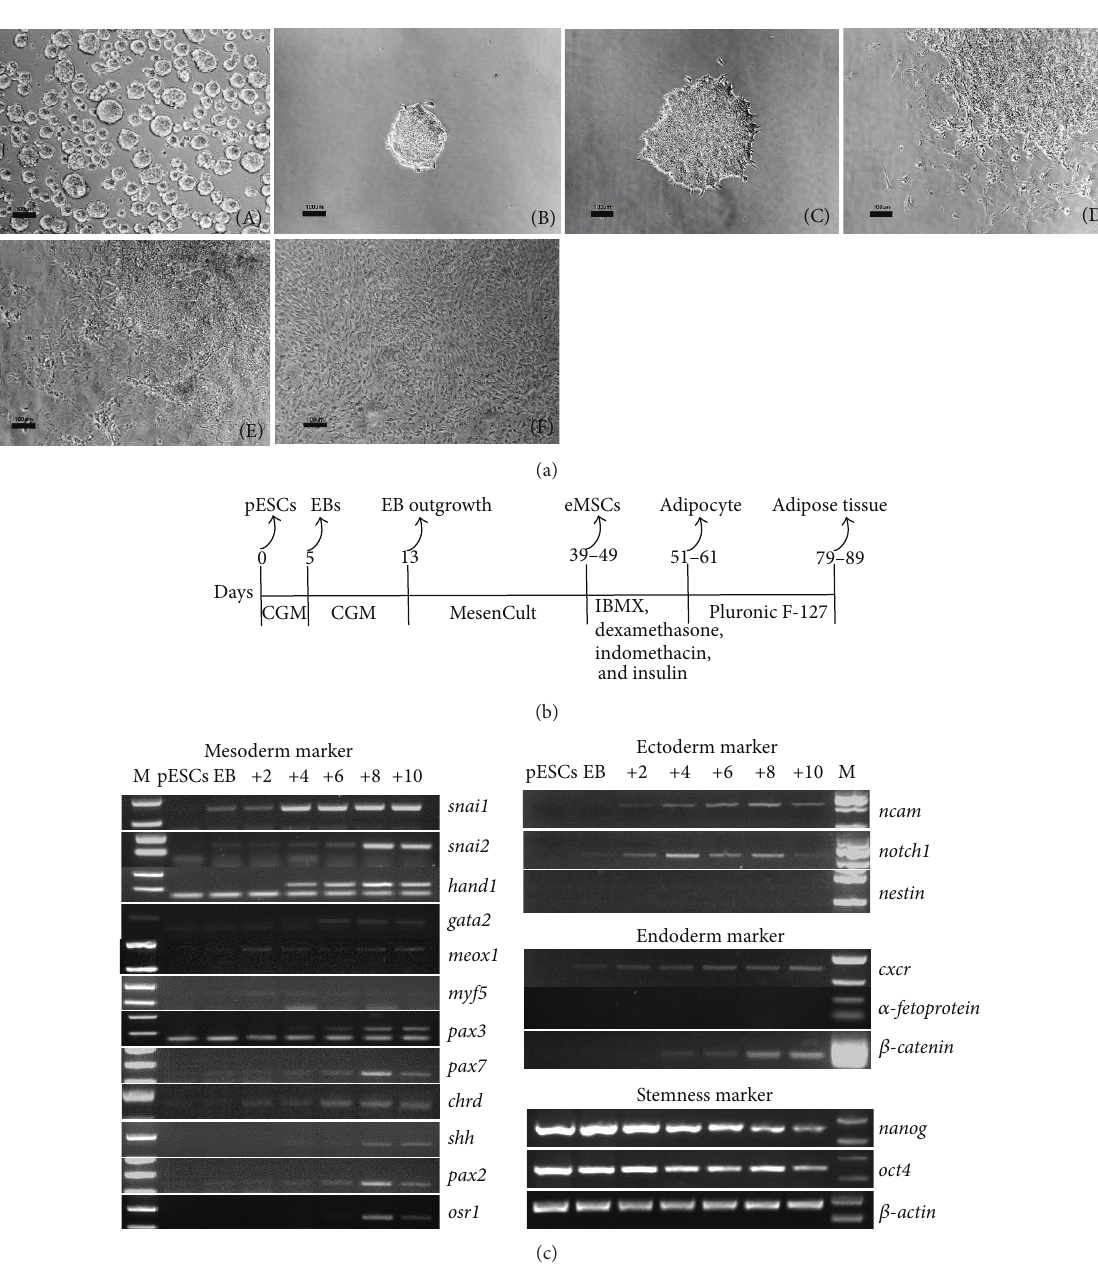
Figure 2: (a) Morphological appearance of pESC-derived EBs and outgrowths of EBs. (A) Micrograph of pESC-derived EBs. ((B) ∼ (E)) Micrograph of outgrowths from 5d EB plated on gelatin-coated plates for 2, 4, 6, 8, and 10d. (F) Micrograph of eMSCs at passage 3 exhibiting spindle-shaped morphology (bars = 100 𝜇 m). (b) Schematic outlines of pESCs differentiation and adipose tissue engineering flow chart. (c) Transcription of specific markers for mesoderm, endoderm, and ectoderm differentiation. RNA samples from undifferentiated pESCs, EBs (5 days in suspension culture) and (+): subsequent adhesion culture days were analysed by RT-PCR. Nanog and OCT4 are ESCs markers. 𝛽 -actin served as an internal standard for RT-PCR. M. DL2000 DNA